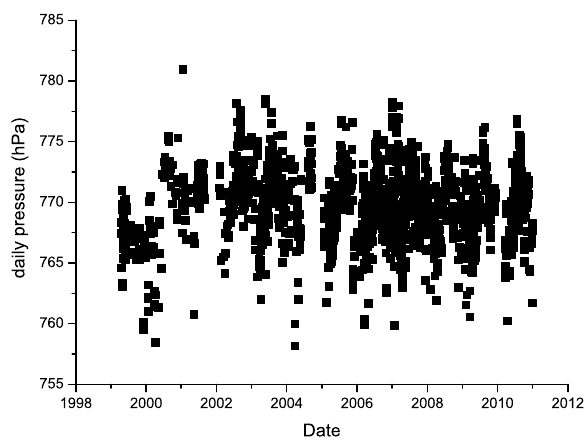
Fig. B1. Time series of the daily mean pressure at Iza˜na ground